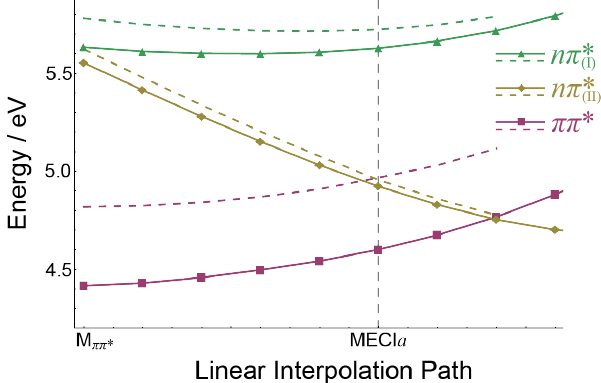
Figure 7. LIP constructed between the M ππ ∗ and MECI a geometries computed at the RI-CC2/cc-pVDZ (dashed lines) and CASPT2/cc-pVDZ (solid lines) levels of theory. The ππ ∗ (bordeaux), n π ∗ (gold) and n π ∗ (green) adiabatic states are indicated. MS-CASPT2/cc-pVDZ excitation energies ( I ) are computed at RI-CC2/cc-pVDZ